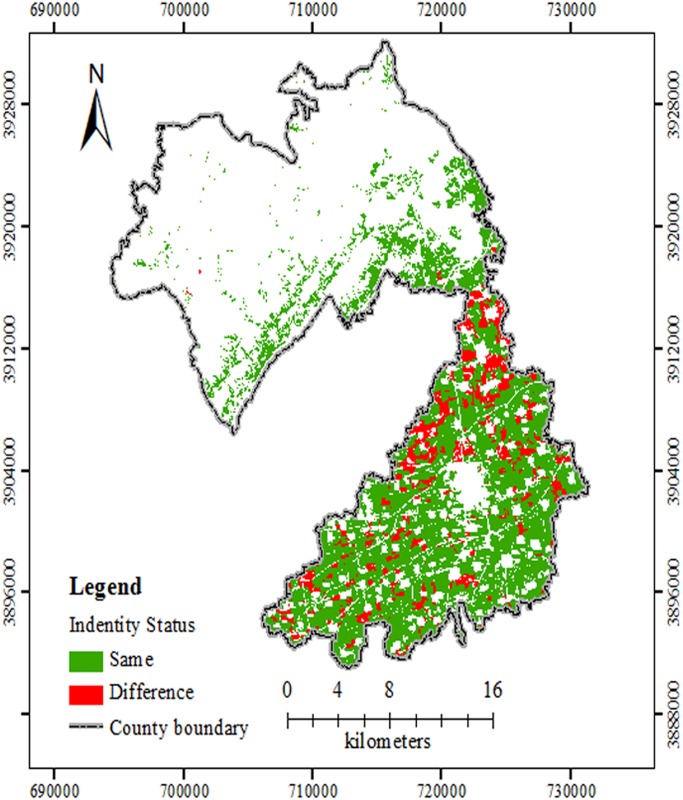
Comparison of FQ results by GCA and AHP in the study site.According to the comparison, there were two indentify status with different colours. Same indicated that FQ evaluation levels by GCA and AHP method for some unites were coincident. Difference meant that FQ levels by two methods did not well agree. Abbreviations: FQ, Farmland Quality; GCA, gray correlation analysis; AHP, analytic hierarchy process.